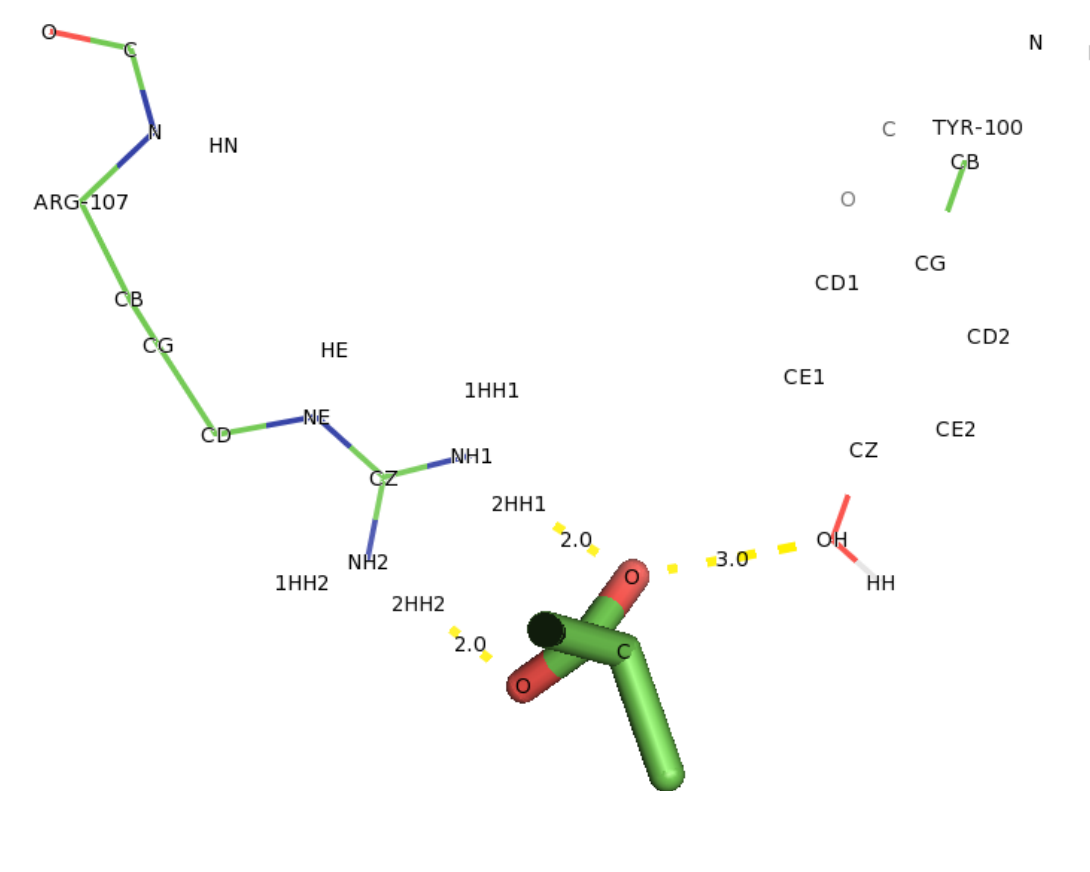
Figure 17. The interacting residues of the double substitution variant of DehD (R134A and Y135A) with D -2CP. Hydrogen bond distances are in